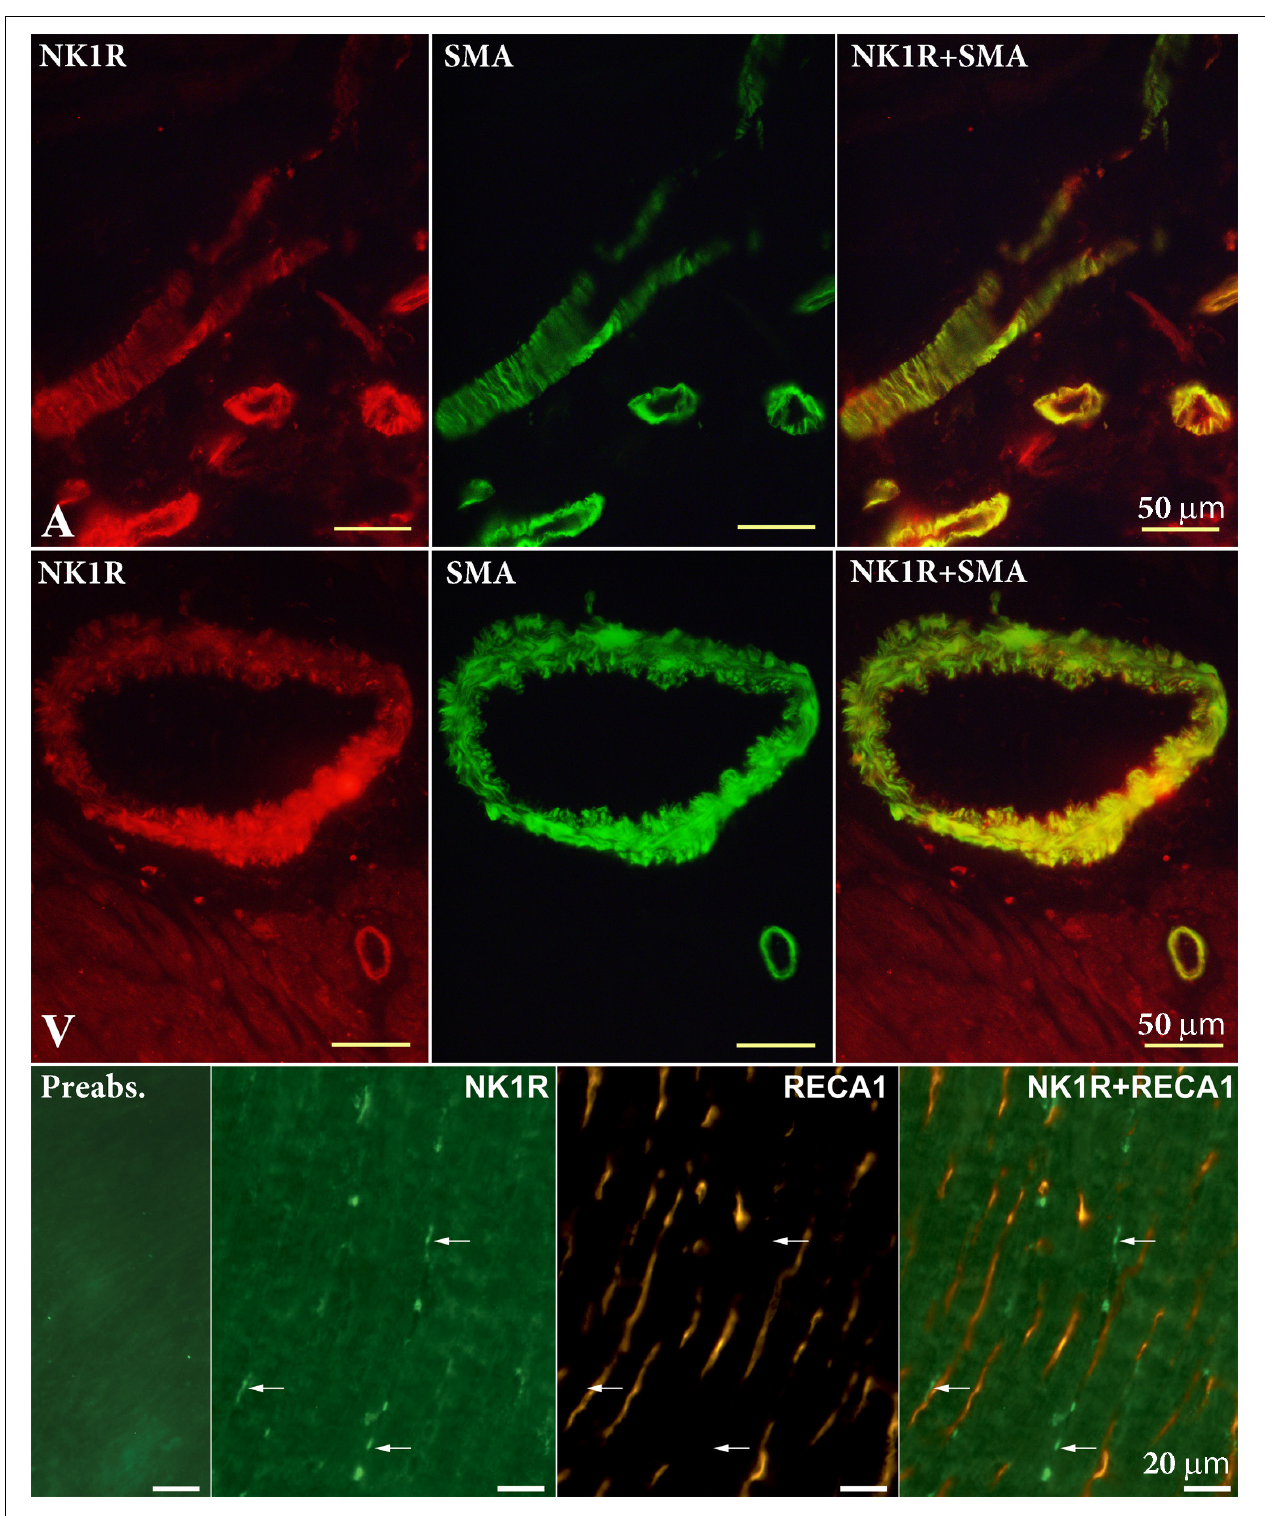
FIGURE 5 | Double-labeling immunohistochemistry for NK1 receptor (NK1R) and smooth muscle actin (SMA) in the atrium (A) and ventricle (V), and rat endothelial cells antibody (RECA-1) in the V. Smooth muscle cells of arteries of different diameters exert NK1R-immunoreactivity. RECA-1 immunoreactive endothelial cells do not show any NK1R immunoreactivity. Anti-NK1R reacted with nerve fibers running between cardiomyocytes (arrows). Preabsorption with appropriate protein shows elimination of fluorescent signal.